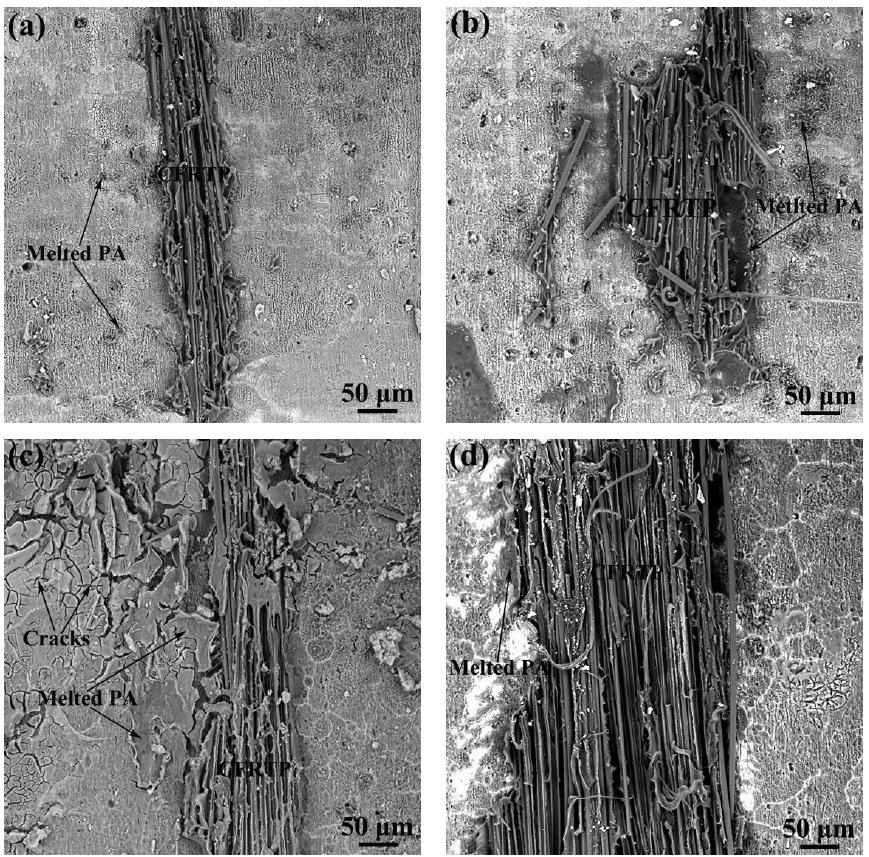
Figure 10. Surface morphology of the different anodizing pretreated butt joint interface after the tensile test: ( a ) anodizing time of 5 min, ( b ) anodizing time of 10 min, ( c ) anodizing time of 15 min, and ( d ) anodizing time of 20